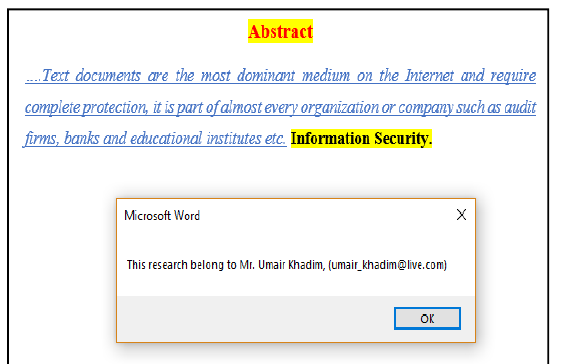
Fig. 9: Robustness result against 90% deletion Attack